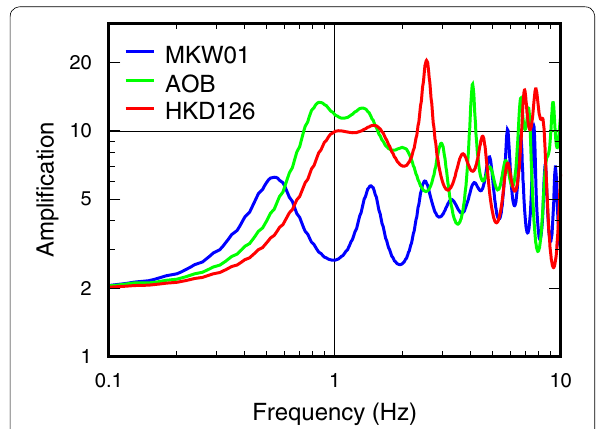
Fig. 13 Theoretical site amplification factor of the SH-wave for three sites. The theoretical site amplification factor calculated with the estimated V s structures in Fig. 9 and Table 2. The SH-wave was assumed to input for 1.3 km/s layer with an incident angle of